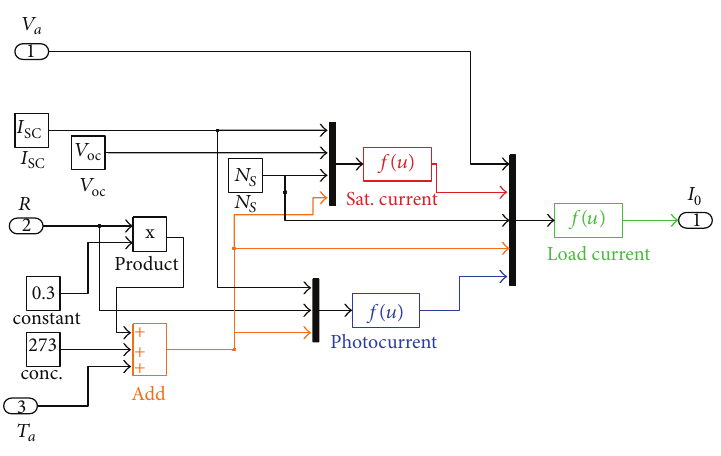
Figure 9: Detailed configuration of PV module subsystem.